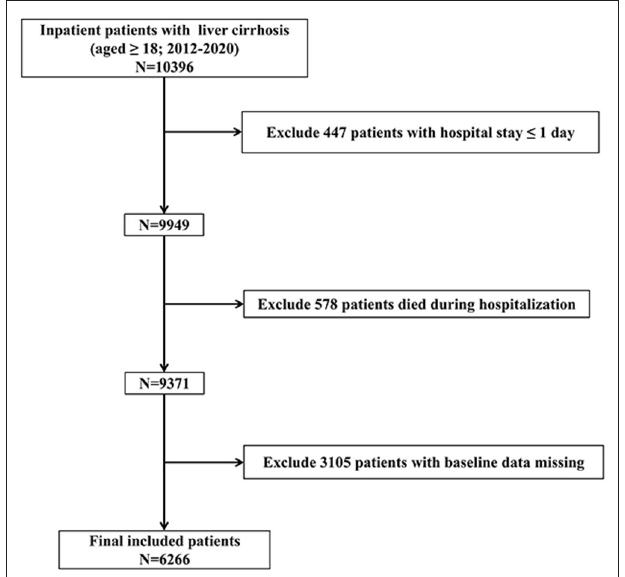
FIGURE 1 | Flow of inclusions and